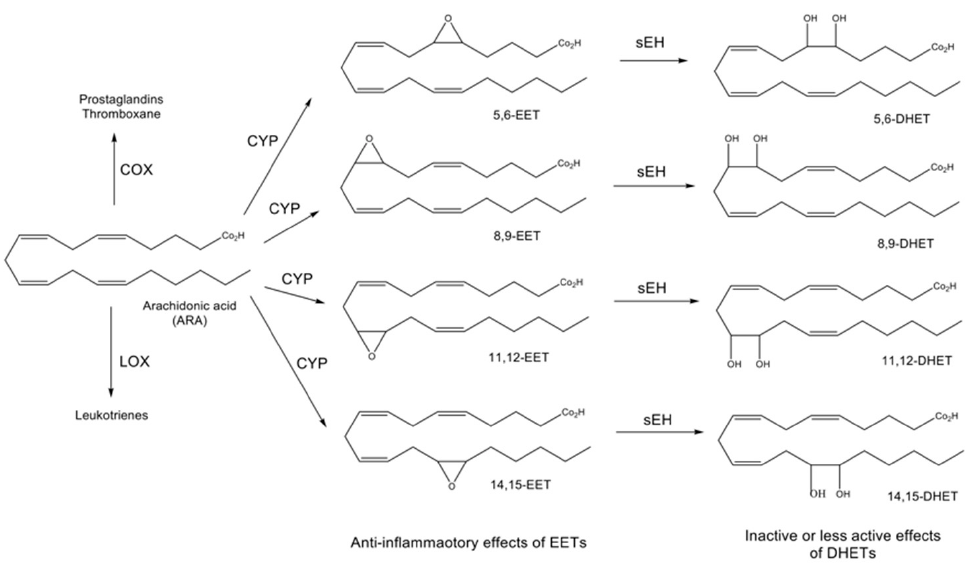
Figure 2. Roles of CYP and sEH in the arachidonic acid (ARA) cascade. In addition to the COX and LOX pathways, ARA is metabolized into four epoxyeicosatrienoic acids (EETs) through the cytochrome P450 (CYP) pathway. EETs are then metabolized into the corresponding dihydroxyeicosatetraenoic acids (DHETs) by soluble epoxide hydrolase (sEH). EETs have anti-inflammatory effects, while DHETs are inactive or have fewer active effects.